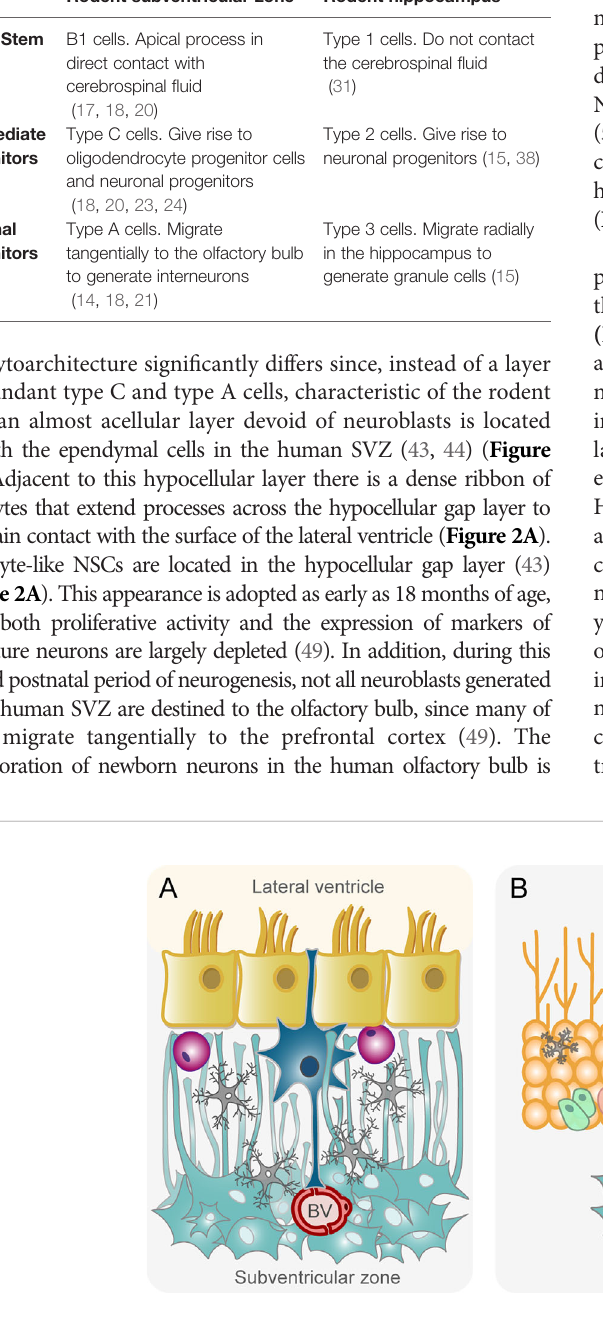
TABLE 1 | Main differences between progenitor cells of the adult subventricular zone and the adult hippocampus in rodents. Rodent subventricular zone Rodent